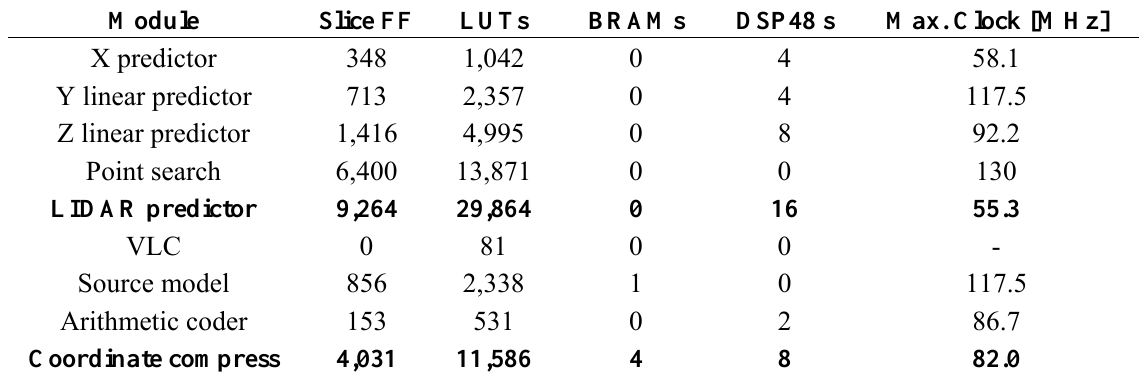
Table 1. FPGA resources utilization for LIDAR compressor modules.